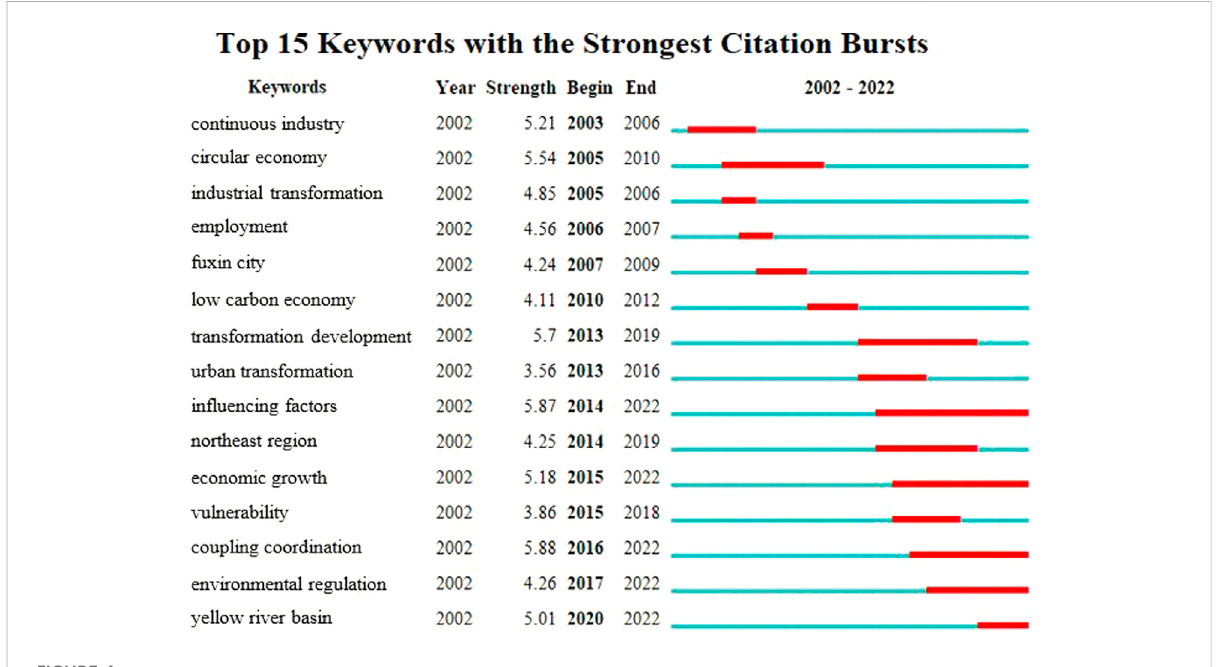
FIGURE 4 Analysis of keyword emergence in the CNKI literature.